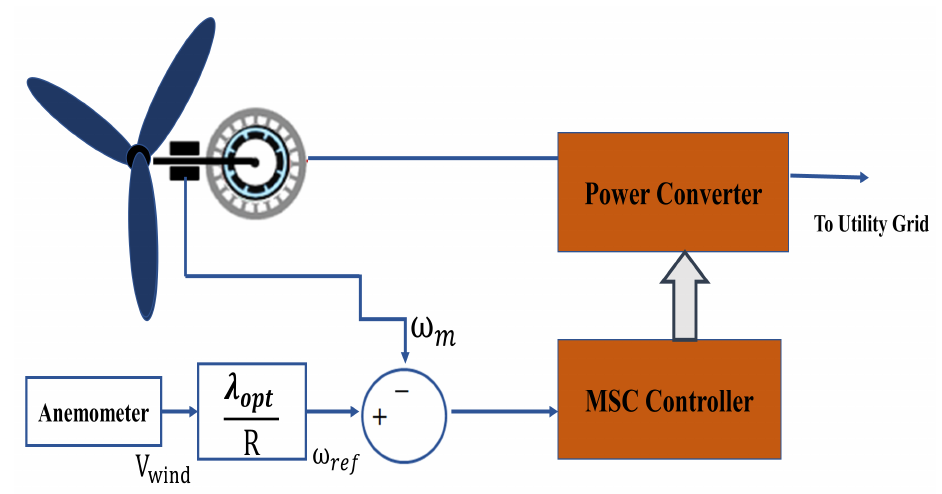
Figure 7. TSR MPPT algorithm.